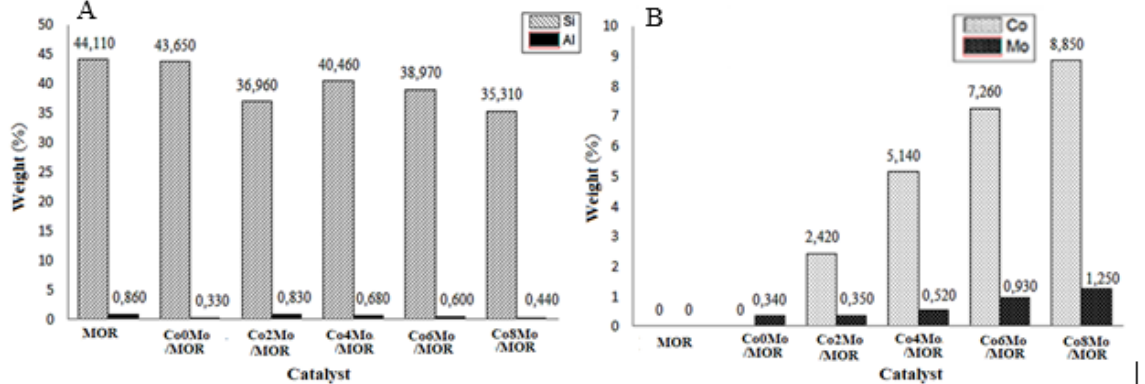
Figure 1: XRF results analysis of MOR and CoMo/MOR.